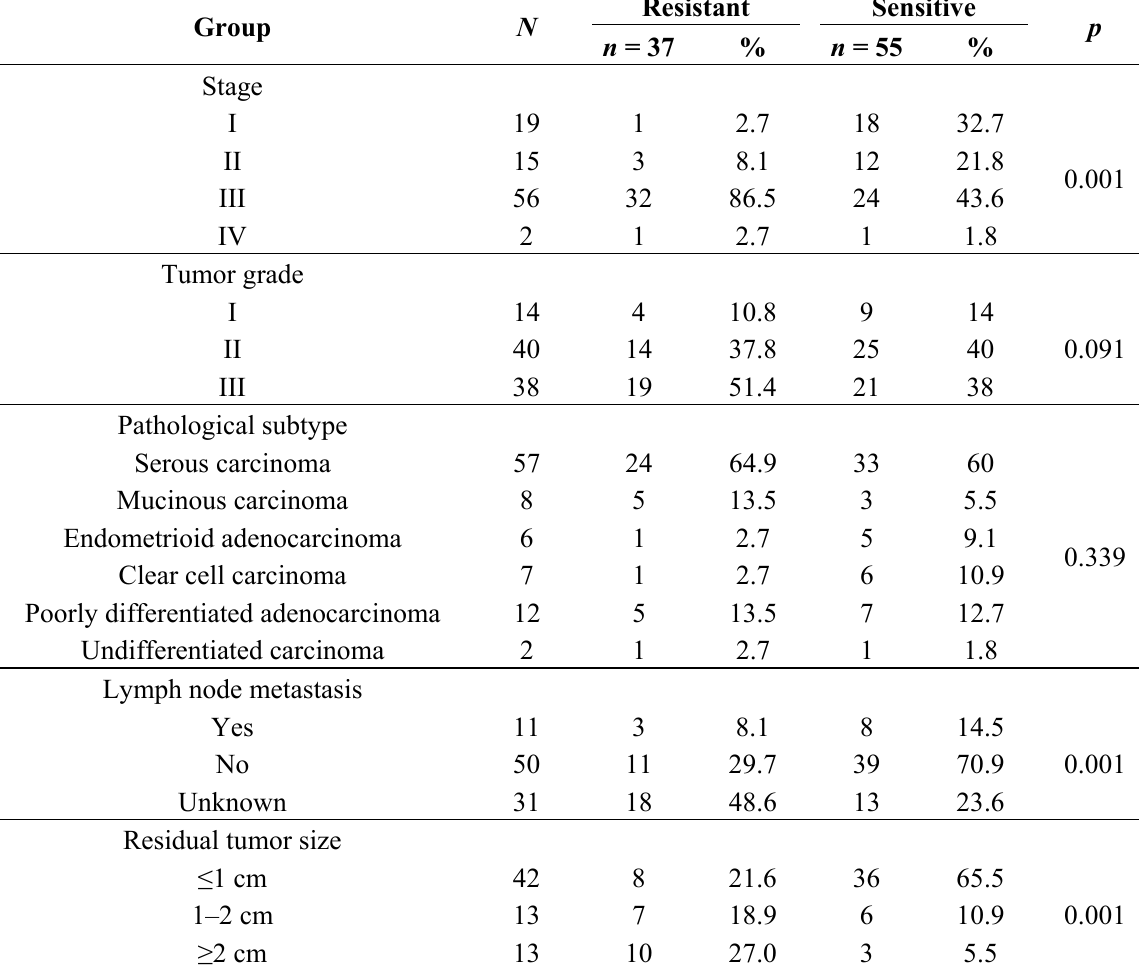
Table 2. Univariate analysis of factors associated with chemoresistance.